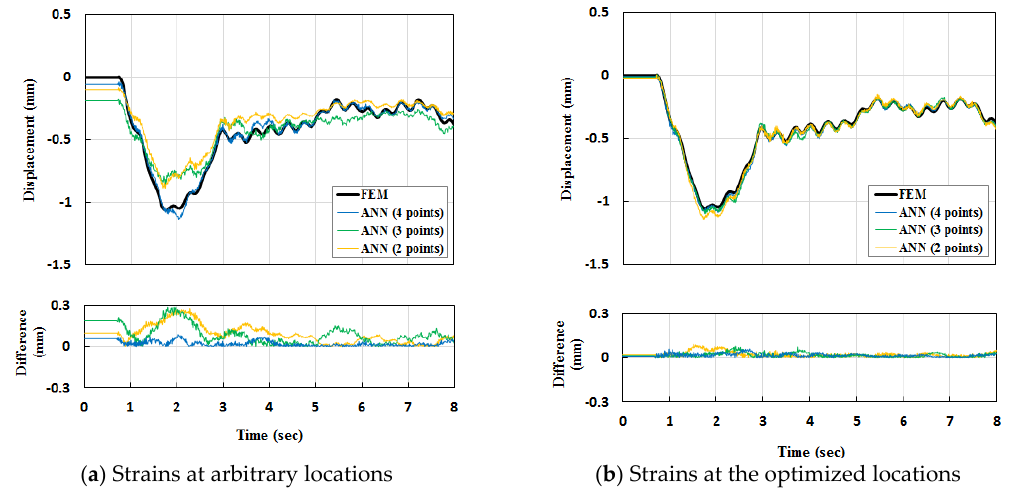
Figure 15. Displacements over time at center girder for 60 km/h test dataset.